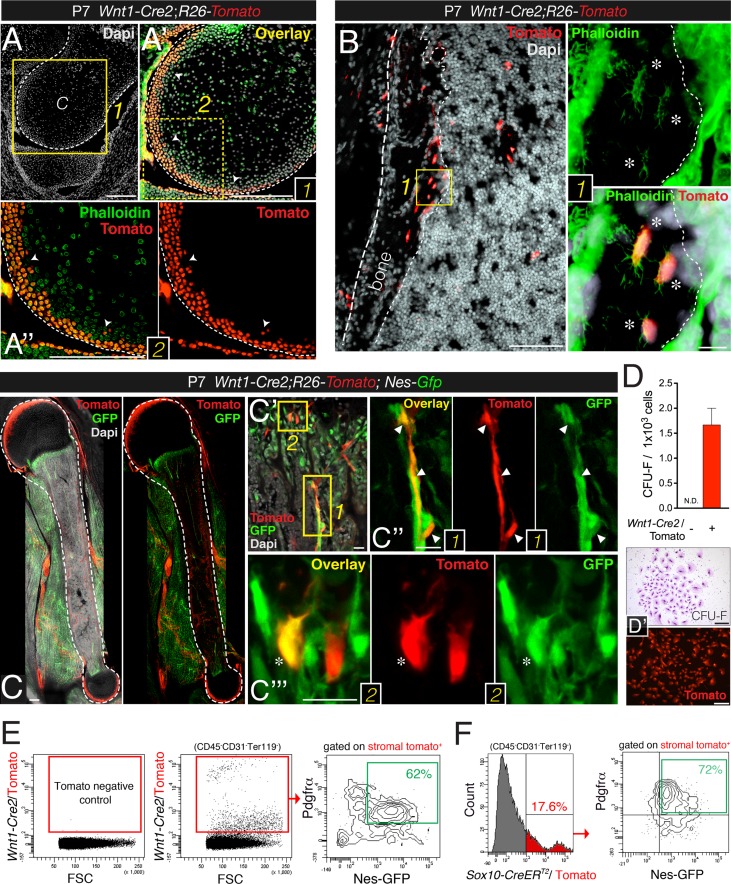
Contribution of trunk neural crest cells to mesenchymal lineages in long bones.(A and B) Fate mapping of neural crest derivatives in femoral bone marrow of neonatal Wnt1-Cre2;R26-Tomato mice. (A) Section through femoral distal epiphysis showing cortical neural-crest-derived chondrocytes (arrowheads, red); green signal corresponds to phalloidin staining. Nuclei were counterstained with DAPI (gray). (B) Bone marrow section showing Wnt1-Cre2-derived Tomato+ (red) osteocytes. (Inset 1) Neural-crest-derived osteocytes (asterisks) in endosteal region, showing their typical morphology revealed by phalloidin staining (green). (C–E) The neural crest contributes to Pdgfrα+ BMSCs in long bones. (C–C′′) Fluorescent signals of GFP, Tomato, and DAPI in bone marrow sections from 1-week old Wnt1-Cre2;R26-Tomato;Nes-Gfp mice. (D) Frequency of fibroblastic colony-forming units (CFU-F) in CD31- CD45- Ter119- Tomato+/- bone marrow cells sorted from 1-week old Wnt1-Cre2;R26-Tomato mice (n = 3); N.D., not detectable. (D′) Examples of Giemsa staining (top panel) and Tomato fluorescence in neural crest-derived CFU-Fs. (E) Representative flow cytometry analysis of bone marrow stromal cells from 4-week old Wnt1-Cre2;R26-Tomato;Nes-Gfp mice. (F) Flow cytometry analysis of bone marrow stromal cells from Nes-Gfp;Sox10-CreERT2;R26-Tomato triple-transgenic mice stained with Pdgfrα antibody. (E, F) Frequencies of neural crest-traced BMSCs are indicated. Scale bars: 200 μm (A–A′′, C, D–D′), 100 μm (B), 20 μm (B1, C′–C′′′). Dashed line depicts the bone and cartilage contour (A–C).